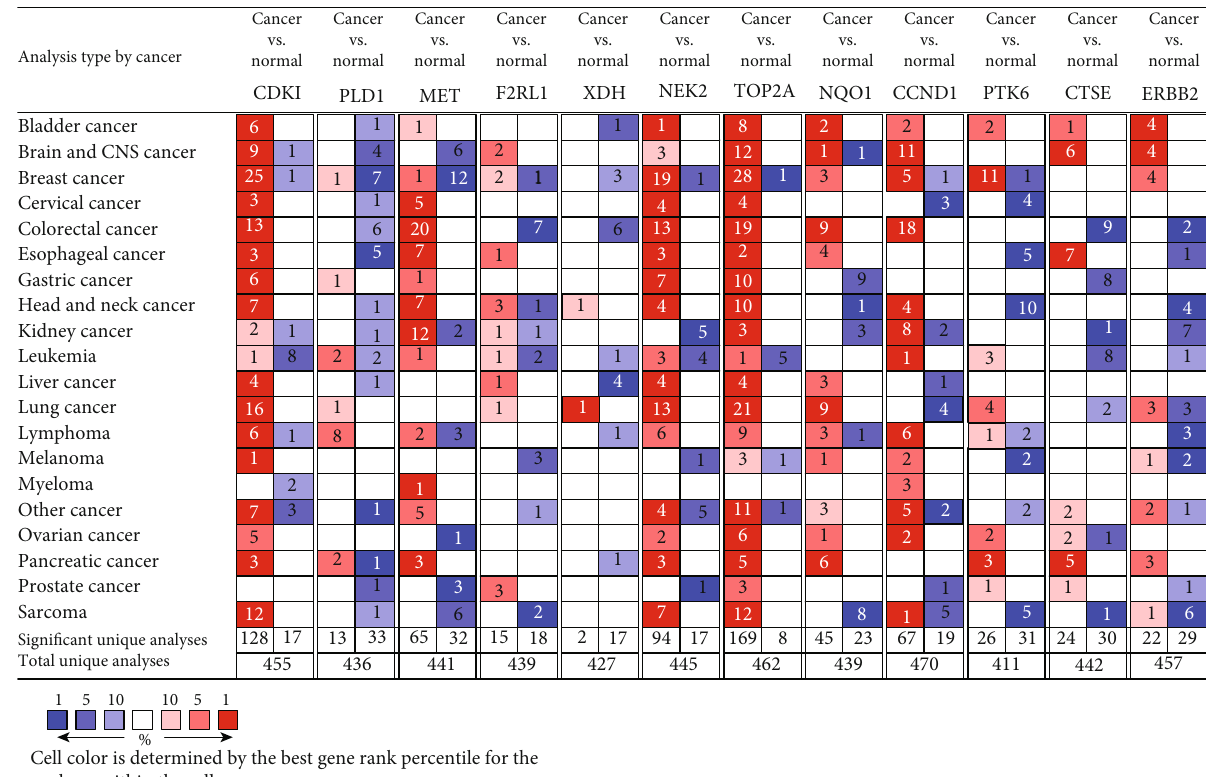
Figure 9: An overview of mRNA levels of 12 overlapped DEGs in 20 di ff erent types of cancers based on Oncomine. The numbers in colored rectangle represent the quantities of datasets with statistically signi fi cant. P-value: 0.05, fold change: 1.5, gene rank: 10%, and data type: mRNA was set as the